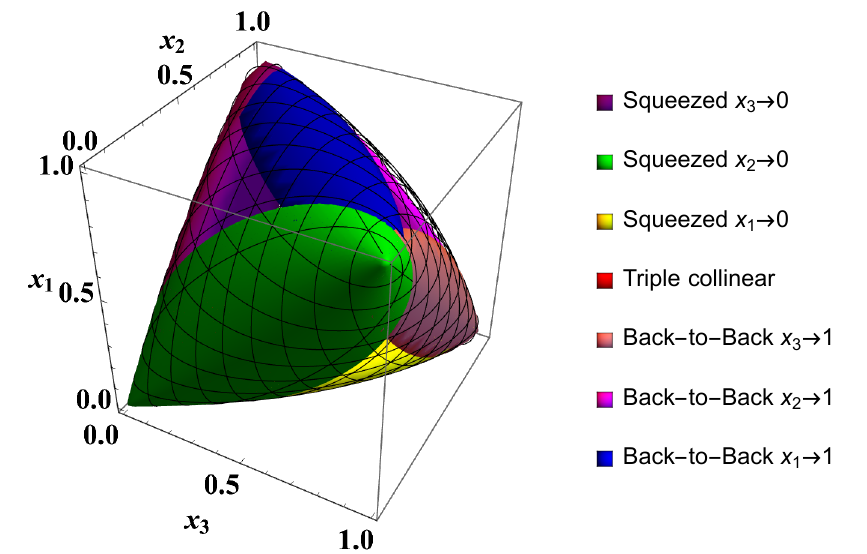
Figure 5 . Various kinematic limits in the { x 1 , x 2 , x 3 } “zongzi”-shaped space. We denote the triple-collinear limit, squeezed limits and back-to-back limits using different colors. The coplanar limit corresponds to the boundary of the kinematic space itself. The full 3D dynamic figure can be found in the supplementary material.